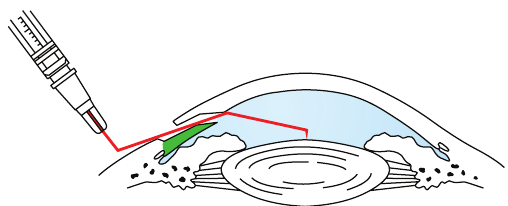
(a) Schematic diagram of 3-bend cystotome: a 3-bend cysto- tome mimics the human arm, with the middle bend acting at the position of the elbow; the posterior arm conforms to the angle of the posterior lip, and the ACD is still kept stable when the anterior arm drives the tip to perform a CCC